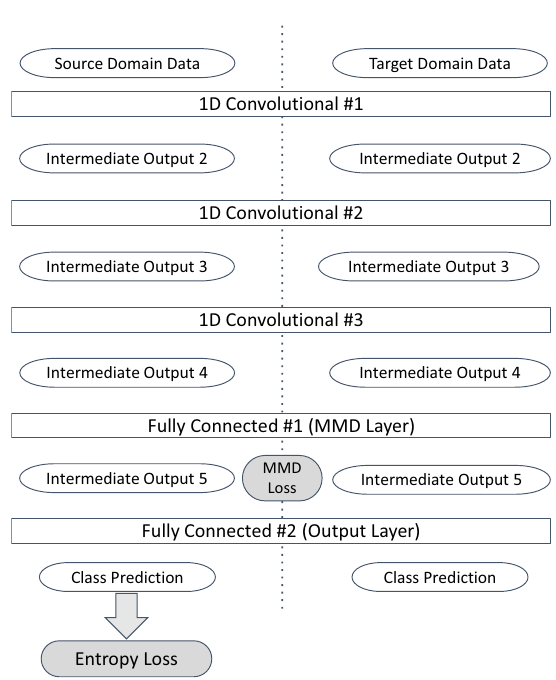
Fig. 6 Architecture of the deep domain adaptation